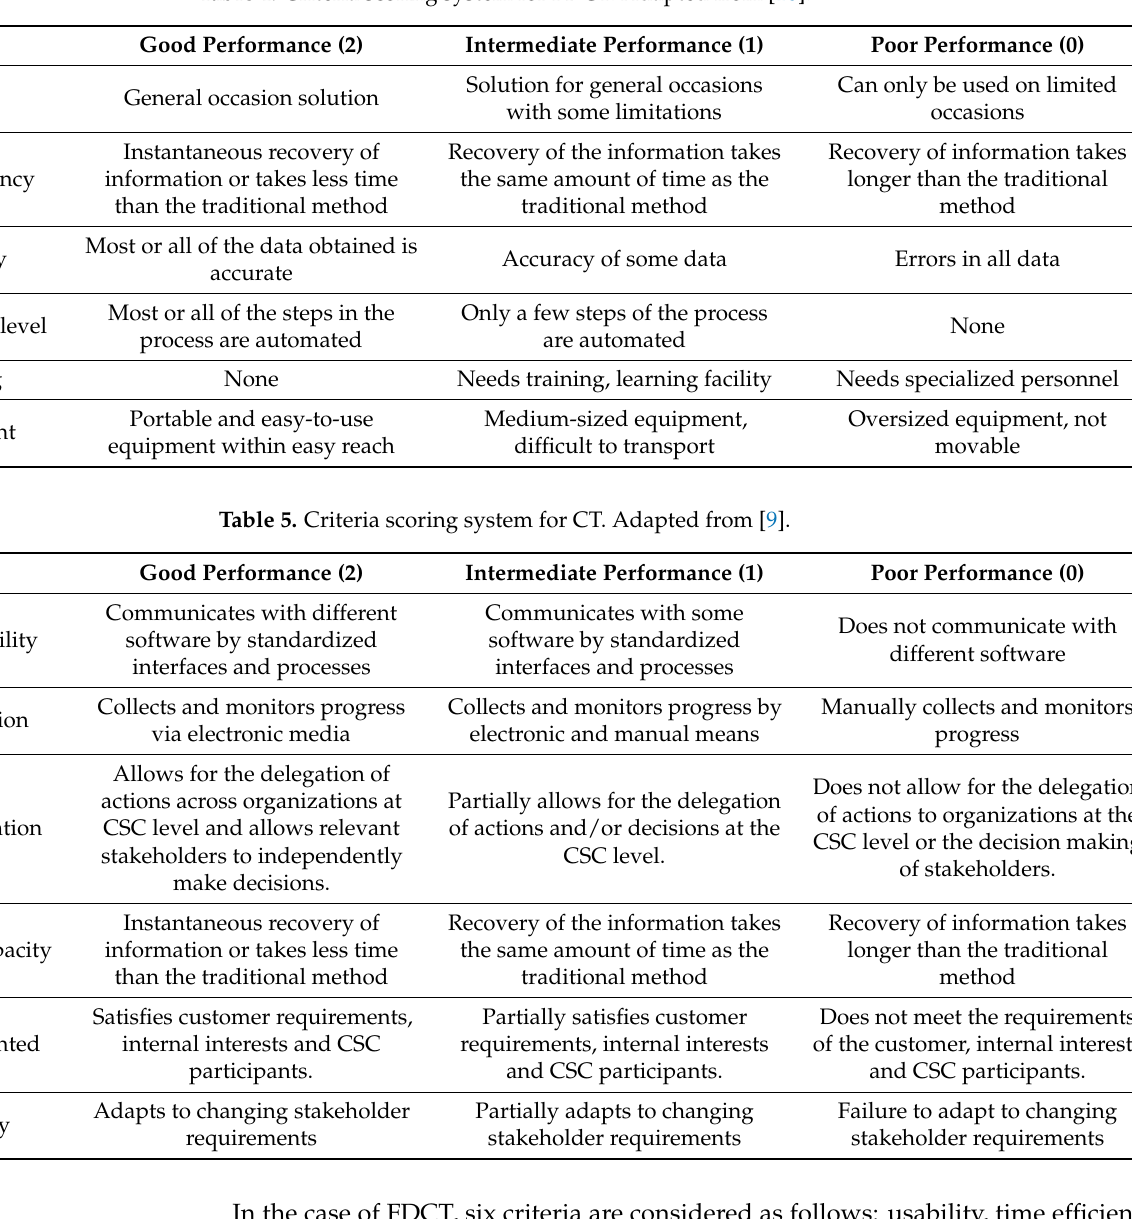
Table 4. Criteria scoring system for FDCT. Adapted from [10].